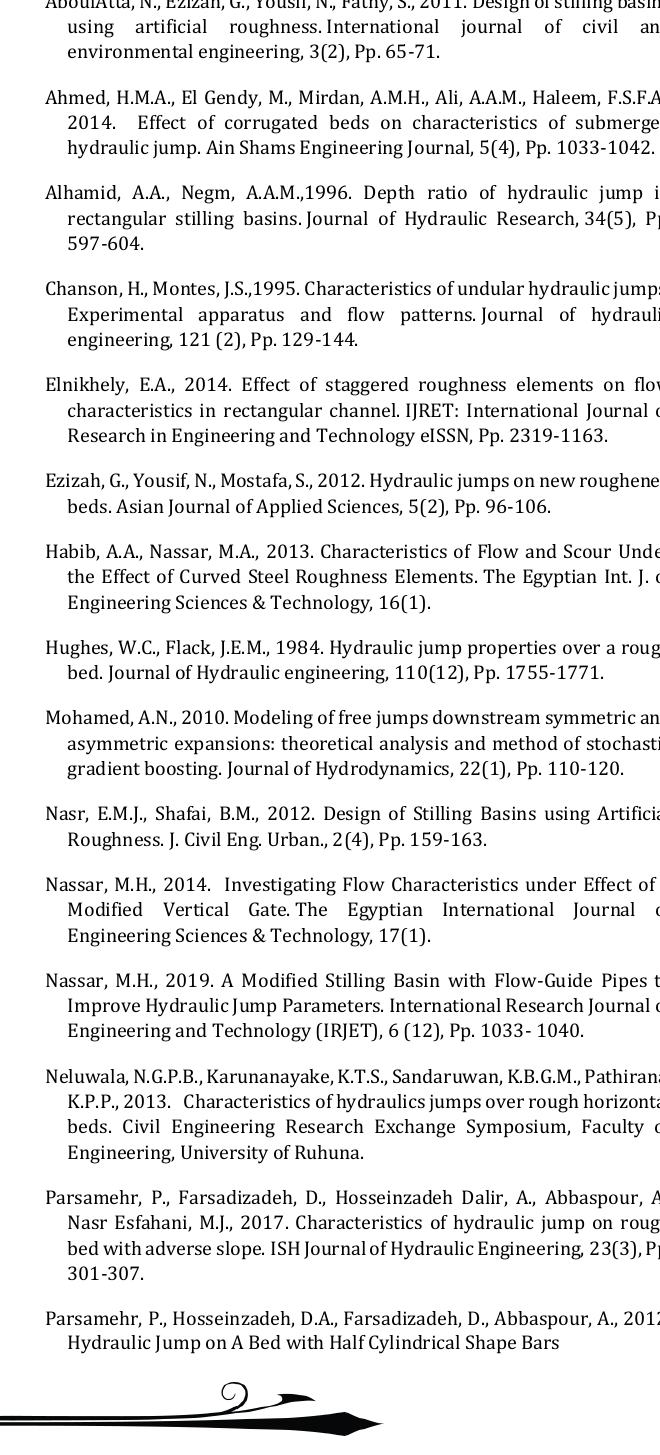
Figure 31: The relationship between the validating values of the comparative lost energy Eq. (4) and the experimental measurements.